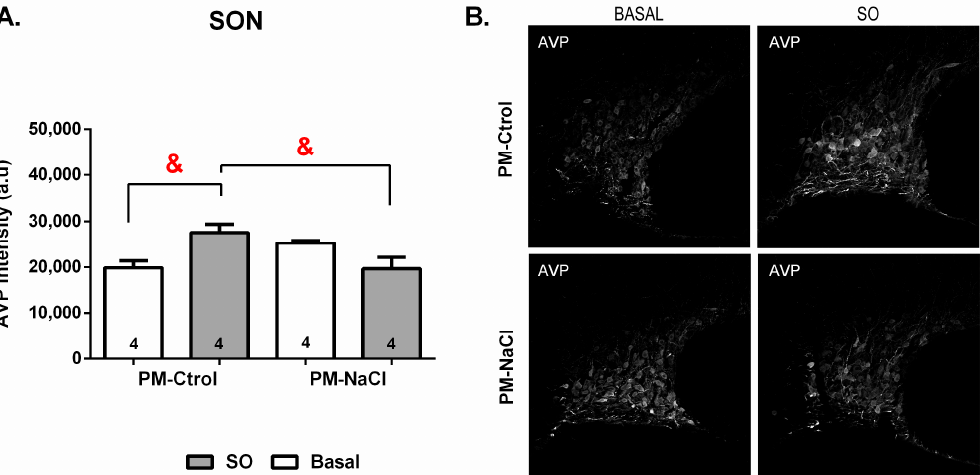
Figure 6. ( A )-Sodium programming effects on immunofluorescence for AVP in the hypothalamic supraoptic nucleus (SON). The numbers inside the bars represent the number of animals in the group. Values are means ± SE. & significant difference at p < 0.05 between PM-Ctrol SO vs. PM-Ctrol Basal and PM-NaCl SO. ( B )-Photomicrography showing the immunofluorescence pattern of AVP-positive cells within the SON.